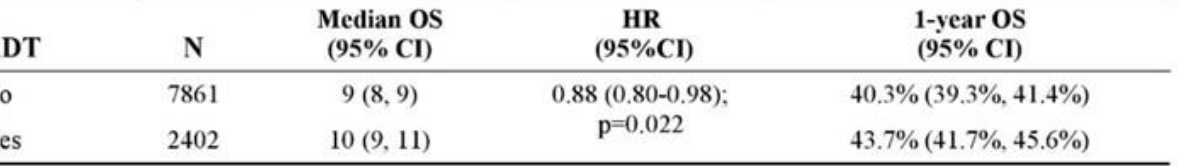
Figure 2. Kaplan–Meier plot for overall survival (OS) in P-L subgroup comparing patients treated with and without